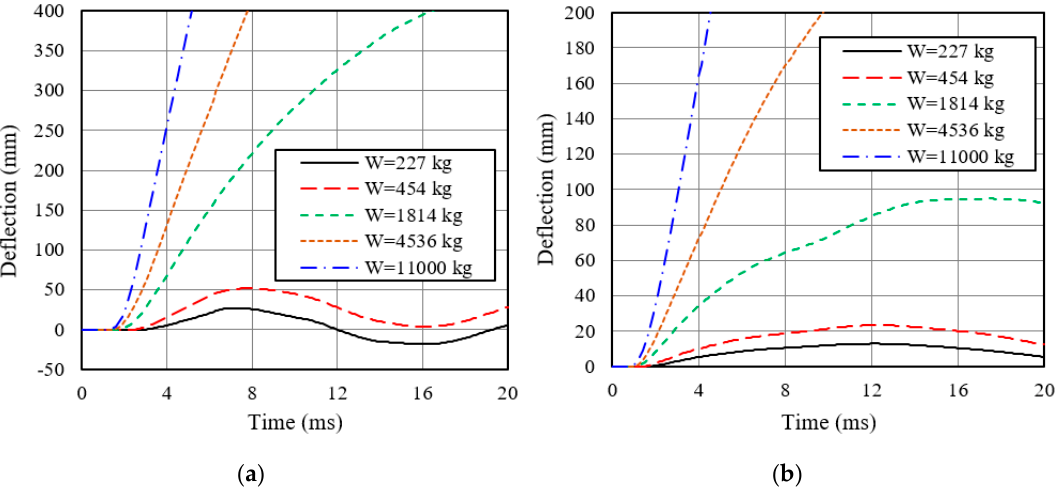
Figure 14. Deflection histories of beam and column for through-diaphragm large CFT connection. ( a ) Beam; ( b ) column.